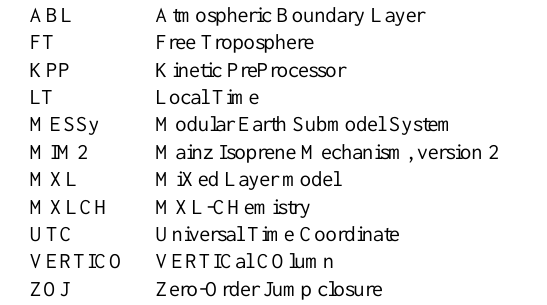
Table B1. List of acronyms used in this work.